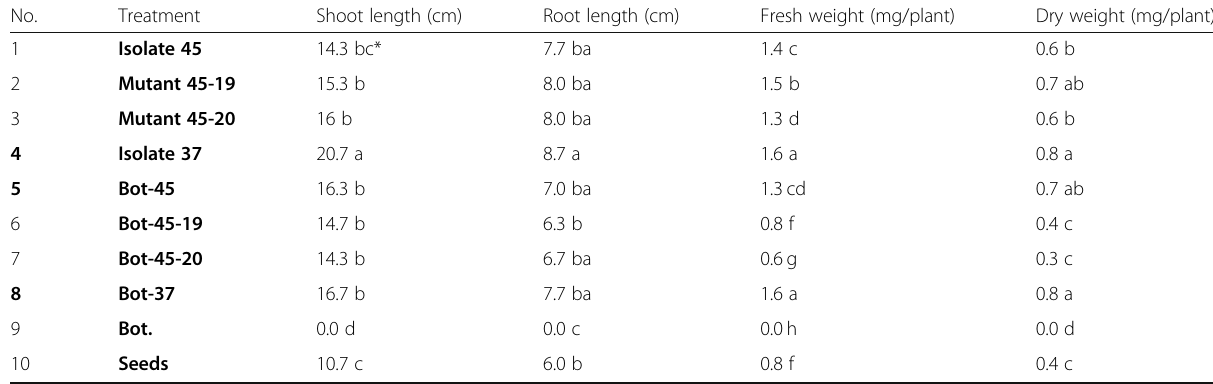
Table 6 Thirty days after inoculation: shoot and root measurements of alfalfa plants under different treatments No. Treatment Shoot length